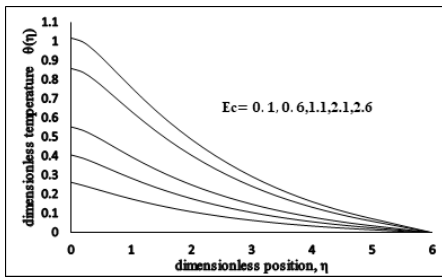
Figure 14. Dimensionless Temperature vs Ec .